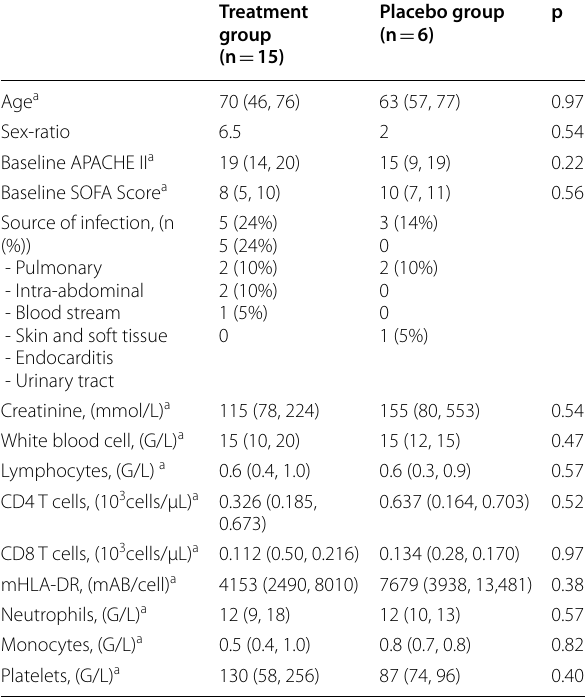
Table 1 Patient